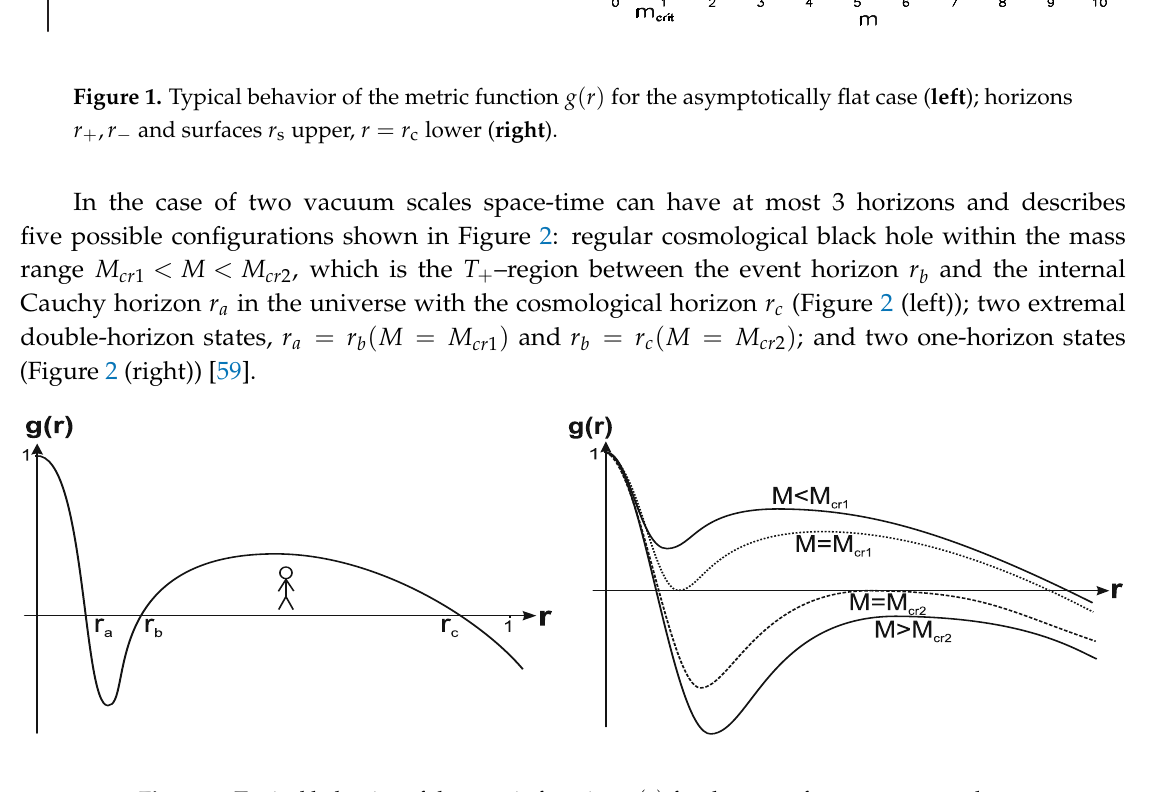
Figure 2. Typical behavior of the metric function g ( r ) for the case of two vacuum